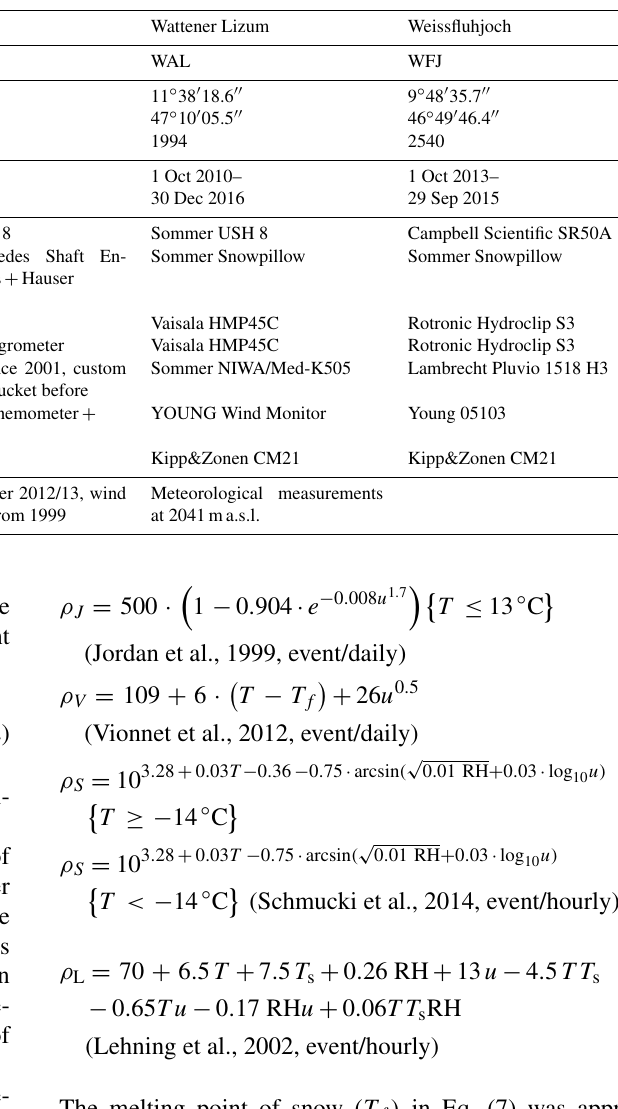
Table 1. Coordinates and data availability are given for the four snow stations. The instrumentation for measuring snow depth (HS), snow water equivalent (SWE), temperature ( T ), relative humidity (RH), precipitation ( P ), wind speed ( u ) and global radiation ( r ) is